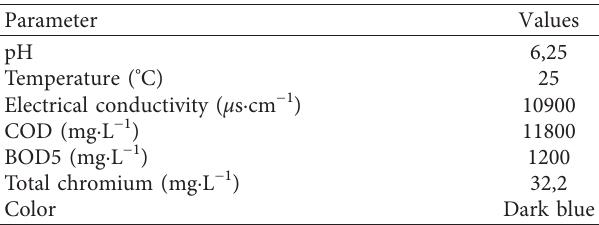
Table 1: Physicochemical characteristics of real tannery